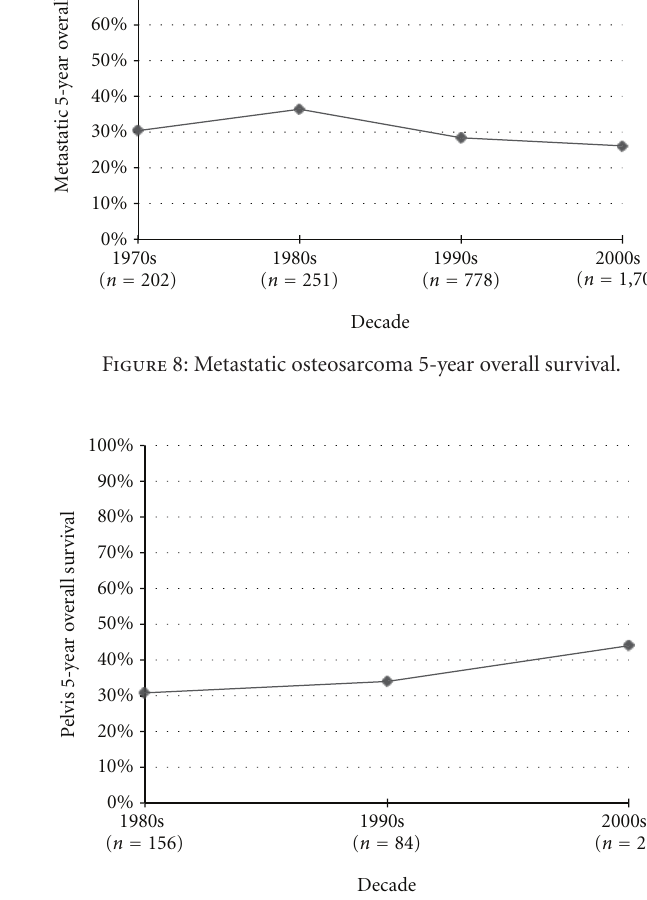
Figure 9: Pelvic osteosarcoma 5-year overall